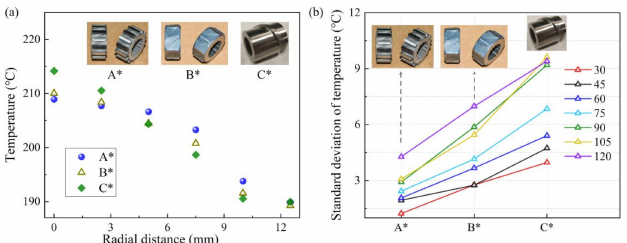
Figure 12. Temperature profile in the extrusion die: ( a ) radial temperature distribution at 75 r/min; ( b ) standard deviation of temperature at different screw